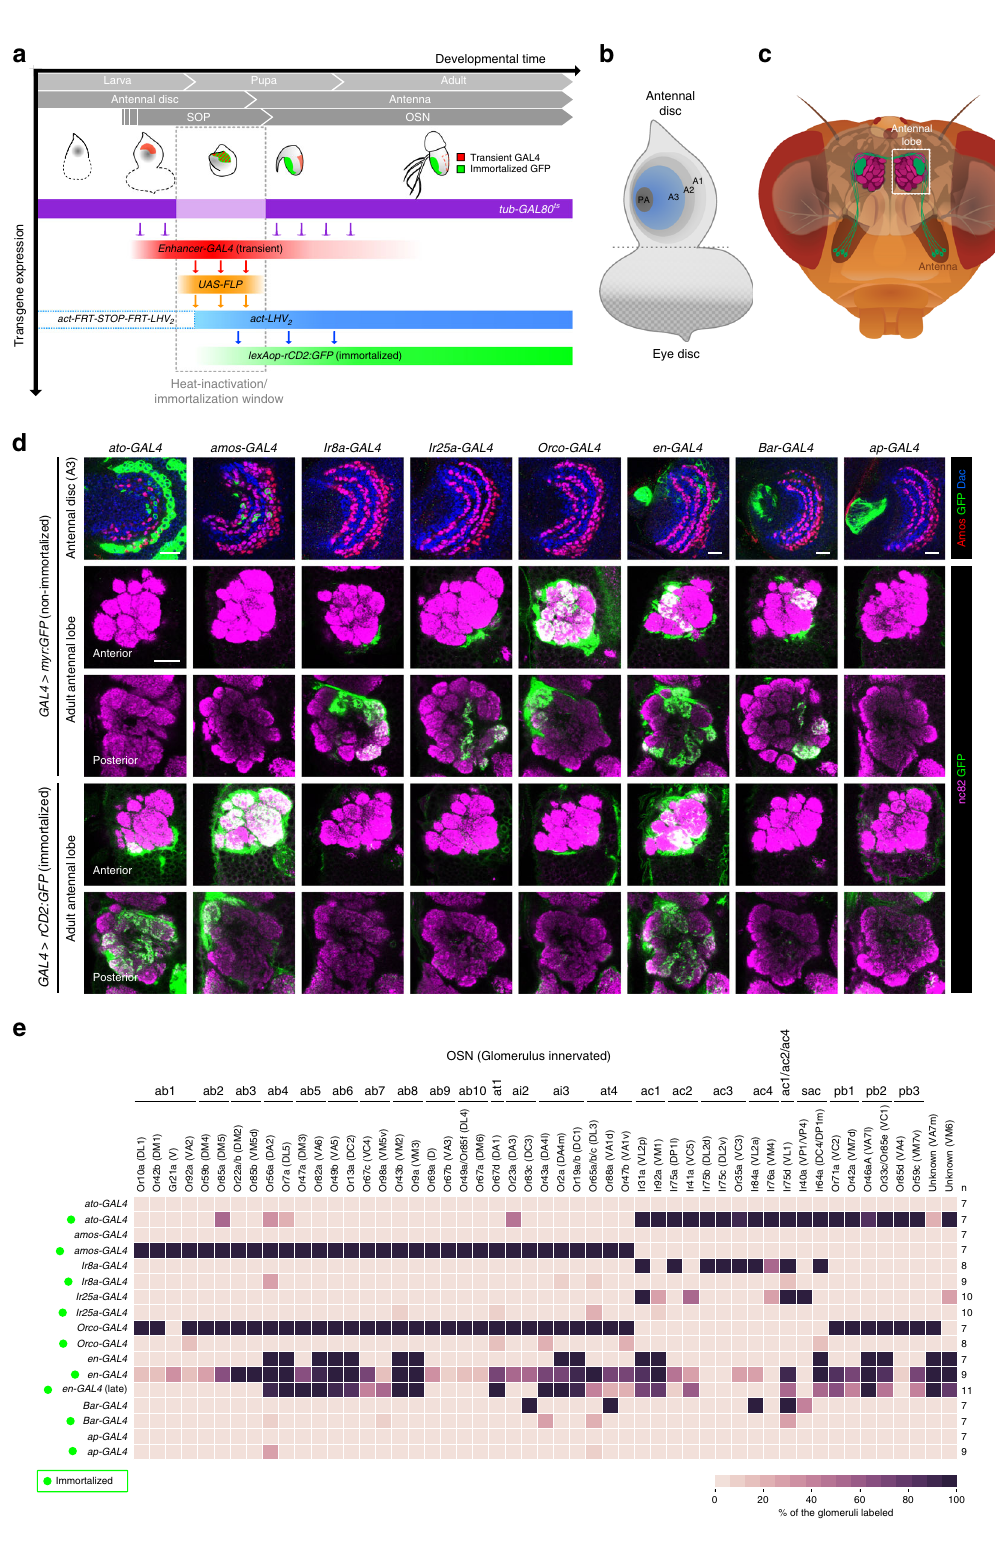
expression of the nonimmortalized GAL4 drivers re fl ects late expression patterns unrelated to their disc expression (Supple- mentary Fig. 1e) and/or labeling of nonantennal neurons (Supplementary Fig.